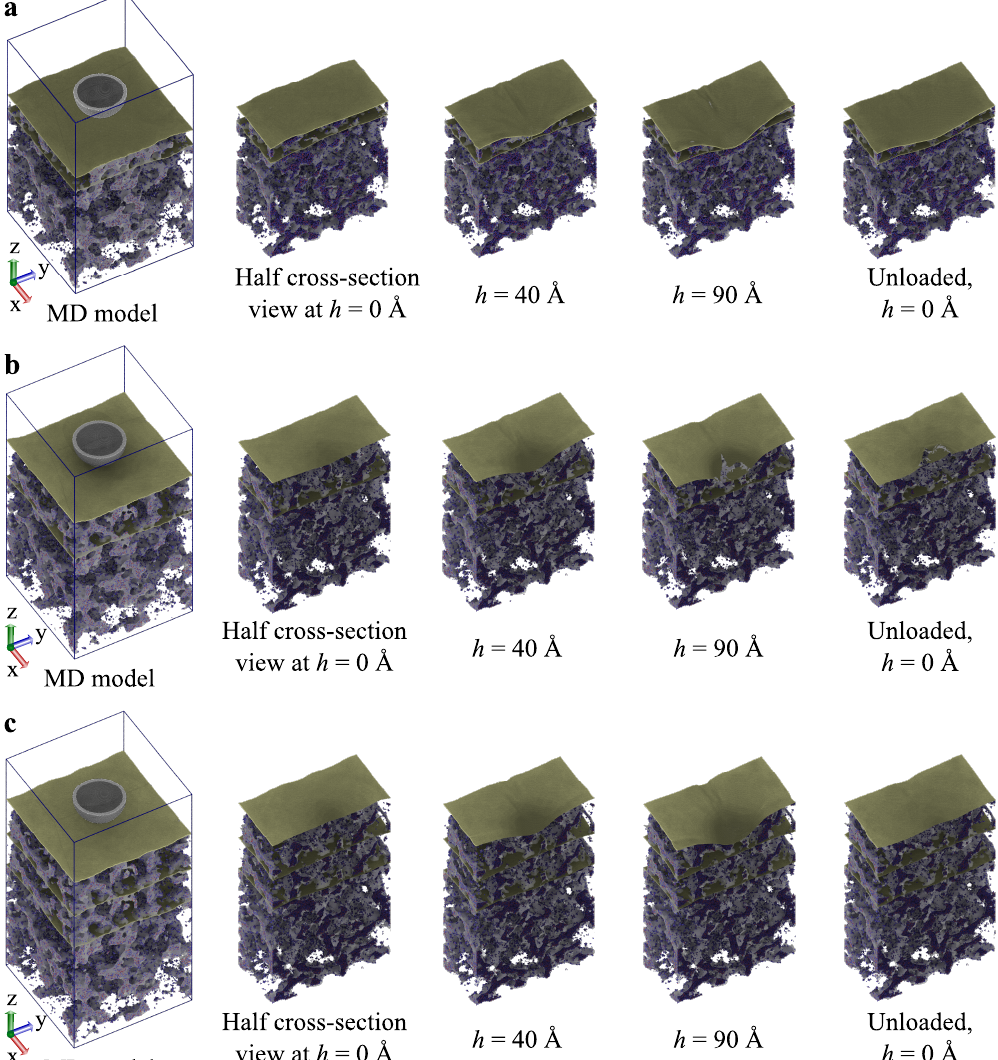
Figure 5. Deformation behavior of a two-layered ( a ) slab Type I, and a two-layered ( b ) and a three-layered ( c ) slab Type II graphene-reinforced silica aerogel nanocomposite observed during nanoindentation